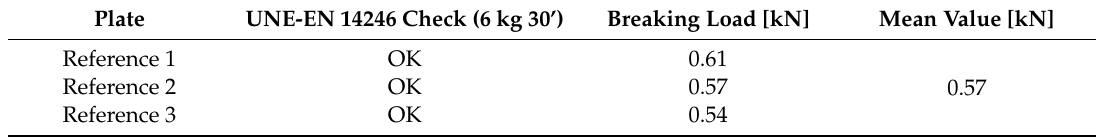
Table 6. Flexural strength test results for the reference plates.